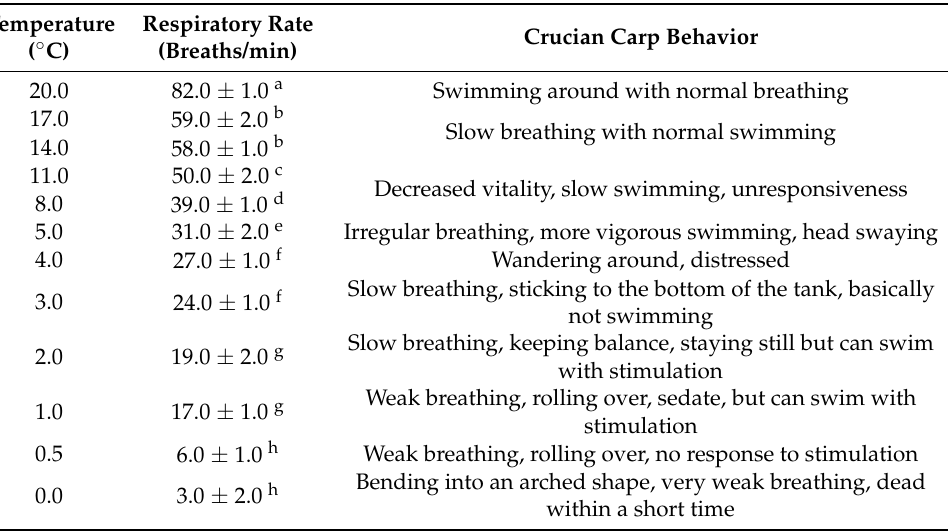
Table 2. Respiratory rate and behavior of crucian carp at different temperatures.